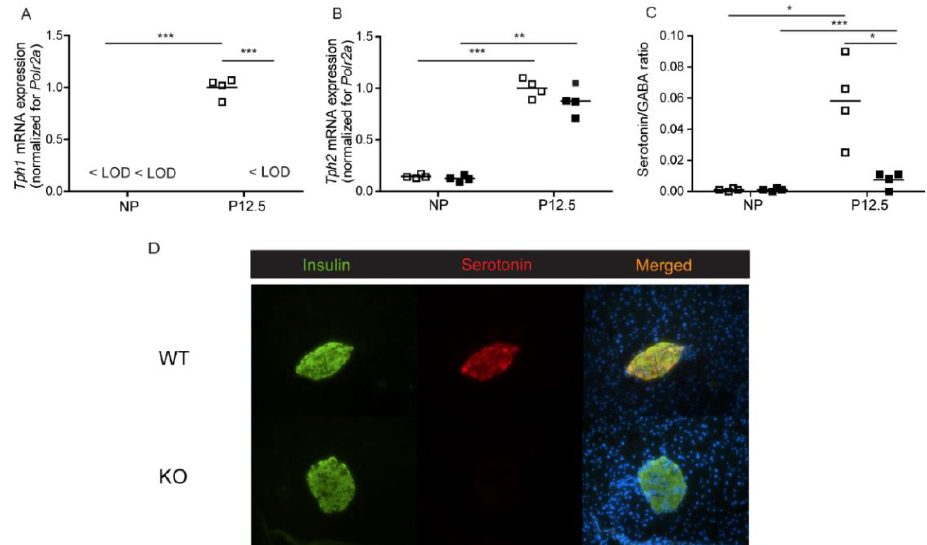
Figure 1. Analysis of serotonin biosynthesis in pancreatic islets of wild-type ( □ ) and total Tph1 KO mice ( ◼ ). ( A ): Tph1 mRNA, quantified by Q-RT-PCR, was below level of detection (<LOD) in islets of non-pregnant animals and in islets of pregnant Tph1 KO mice; in contrast, Tph1 mRNA was strongly upregulated in islets of wild-type mice at P12.5. ( B ): Upregulation of Tph2 mRNA level (quantified by Q-RT-PCR) during pregnancy was comparable in Tph1 KO mice and wild-type mice. ( C ): Islet serotonin/GABA ratios were significantly lower in pregnant Tph1 KO mice as compared to pregnant wild-type mice. Each point in A – C represents the measurement of material sampled from one mouse; mean values are represented by horizontal bars. Significance of differences was calculated by unpaired Student’s -t-tests: * p < 0.05, ** p < 0.01, *** p < 0.001. ( D ): Absence of serotonin immunoreactivity in pancreatic islets of P12.5 Tph1 KO mice. Staining for insulin (green), serotonin (red) and DAPI (blue) on pancreatic sections of wild-type and Tph1 KO mice.